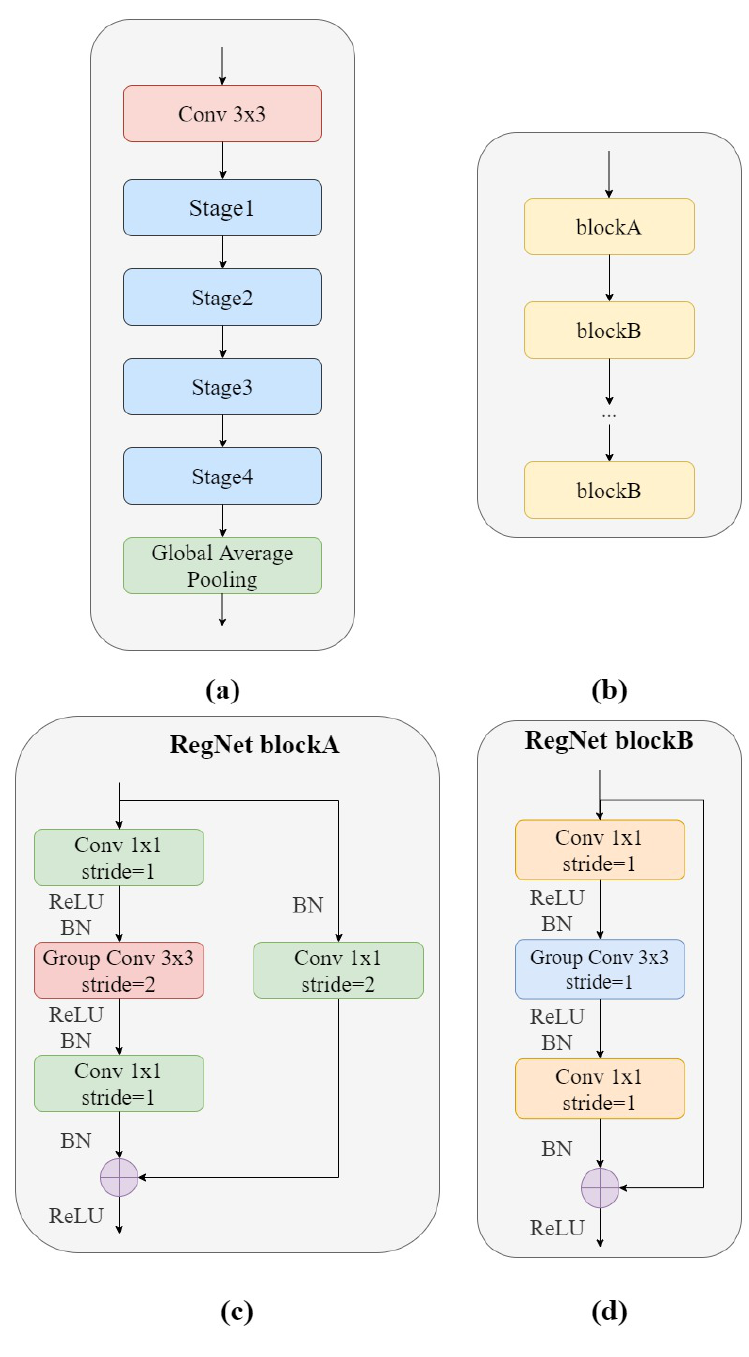
Figure 3. ( a ) RegNet structural framework; ( b ) Detailed structure of stage; ( c ) RegNet block A, Group Conv stride = 2; ( d ) RegNet block B, Group Conv stride =